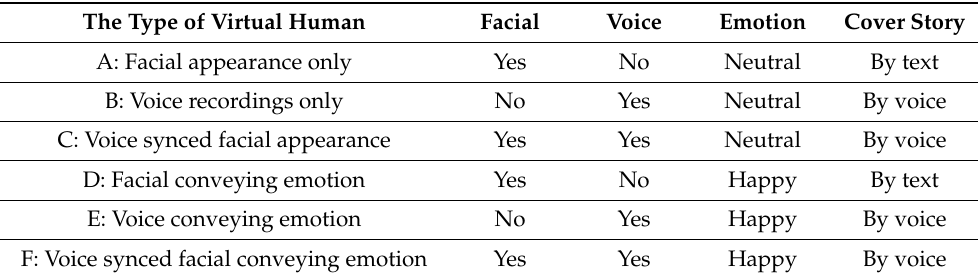
Table 1. The types of virtual humans manipulated in the social facilitation experiment. The Type of Virtual